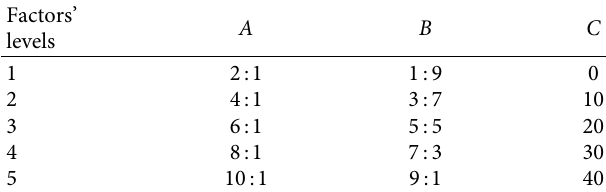
Table 7: Orthogonal design of similar materials. Factors’